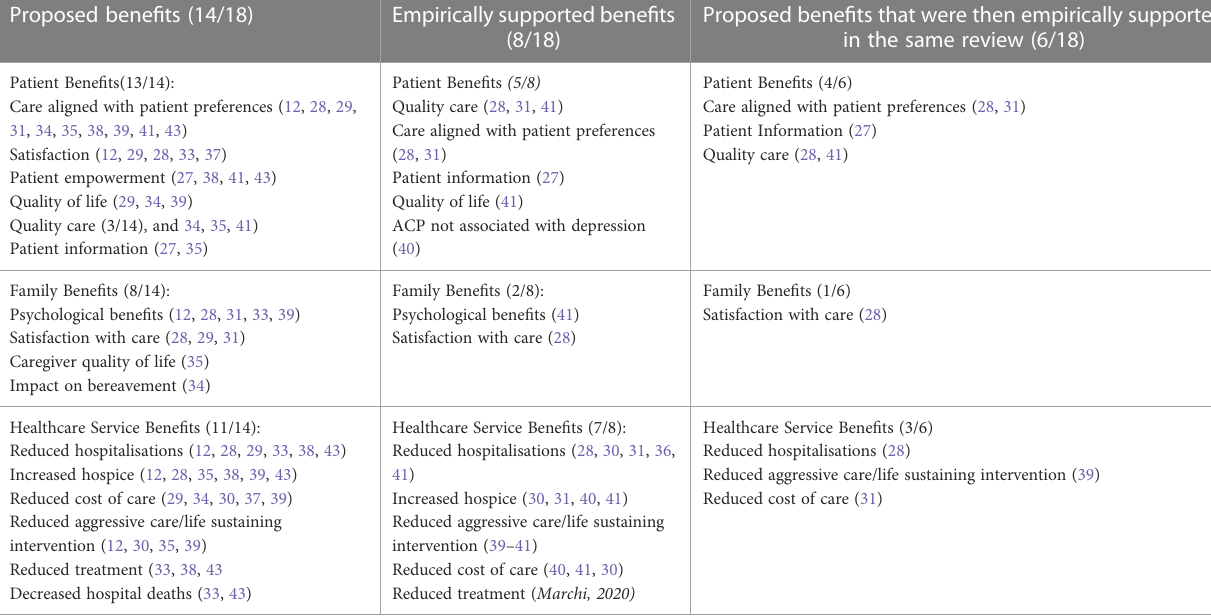
TABLE 2 Summary of proposed and identi fi ed bene fi ts of ACP by content categories and frequencies of sub-categories for each. Proposed bene fi ts (14/18) Empirically supported bene fi ts Proposed bene fi ts that were then empirically supported (8/18) in the same review